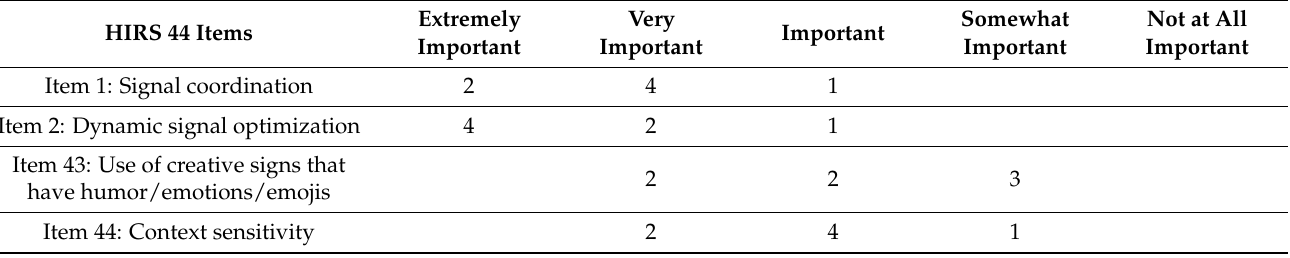
Table 2. Sample of experts’